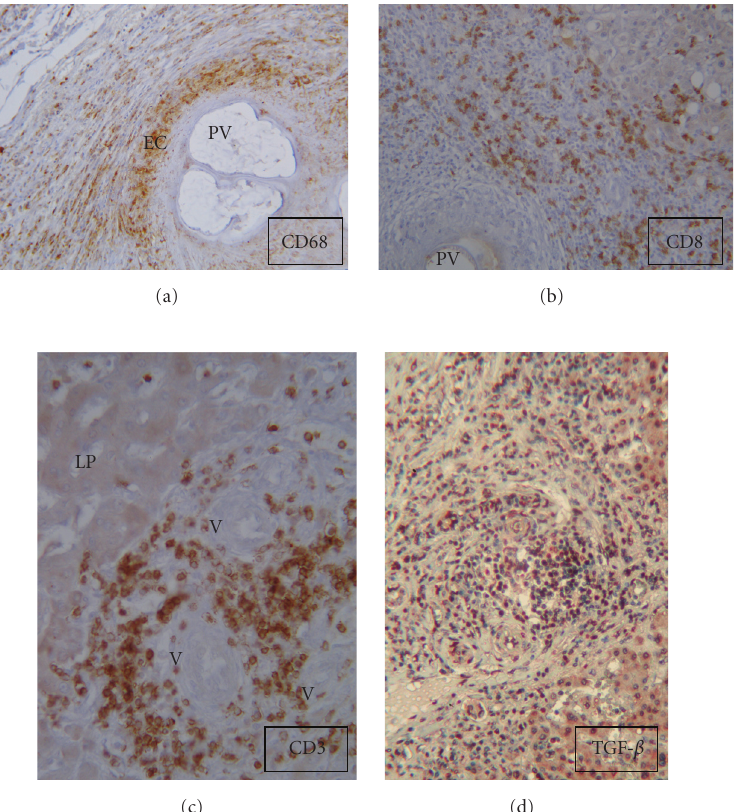
Figure 2: Cells of the periparasitic granuloma in E. multilocularis infection in humans; immunostaining of liver sections of patients with alveolar echinococcosis. (a) the “epithelioid cells” (EC) are CD68+ macrophages with an epithelium-like arrangement, located at close contact to the laminated layer of the parasitic vesicle (PV); (b) CD8+ T-cells represent the major cell population of the periparasitic infiltrate; (c) infiltration by CD3+ T-cells is especially prominent around the new vessels (V) developed at the periphery of the granuloma, at the border of the invaded liver parenchyma (LP); (d) most of the infiltrating T-cells express TGF- β. (Photo: B. Kantelip and DA Vuitton, WHO- Collaborating Centre; Universit´e de Franche-Comt´e, Besanc¸on,